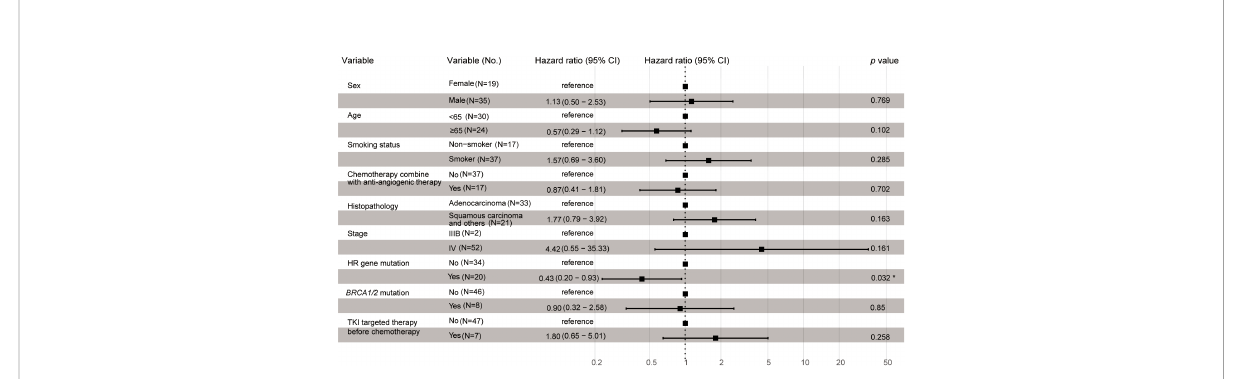
FIGURE 2 Multivariate Cox proportional hazard regression analysis of potential factors associated with progression-free survival. The asterisk indicated a statistically signi fi cant difference, that was, the p-value is less than 0.05.